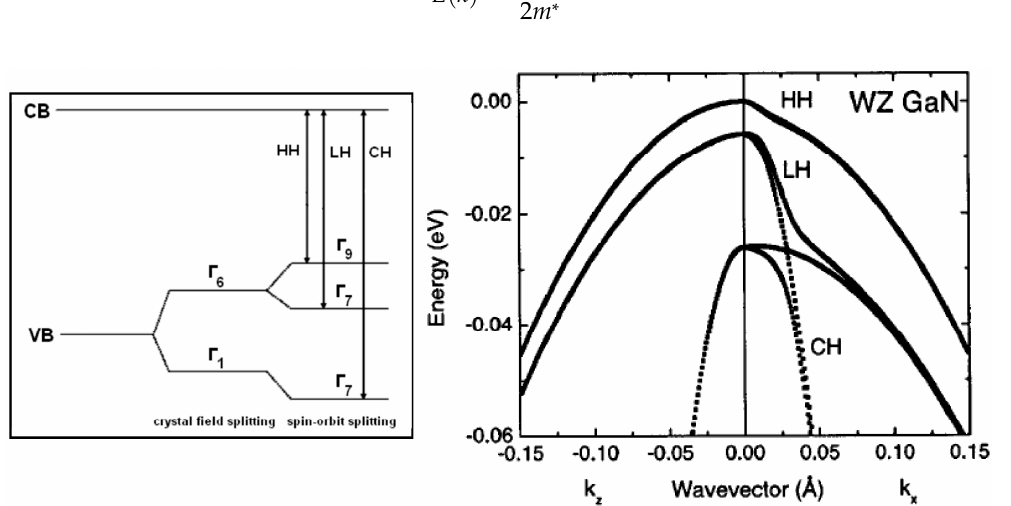
Figure 3. ( left ) Crystal field and spin–orbit interaction in wurtzite GaN [33,61–64] leading to the sub-bands of heavy (HH), light (LH), and crystal-field split-off holes (CH); ( right ) valence band structure of wurtzite GaN with three-split valence bands reproduced from [64] with the permission of AIP Publishing (in the wurtzite structure, crystal-field splitting appears due to the structural anisotropy parallel and normal to the c-axis).